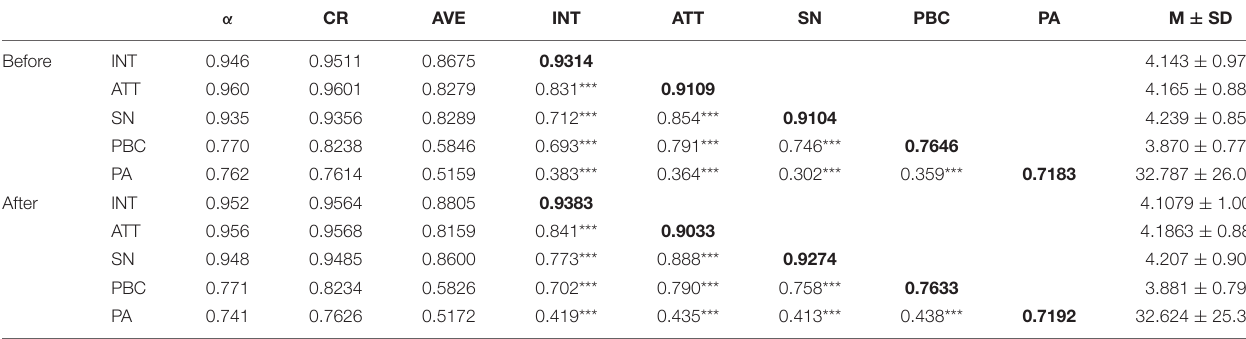
TABLE 2 | Reliability, convergent, and discriminant validities. α